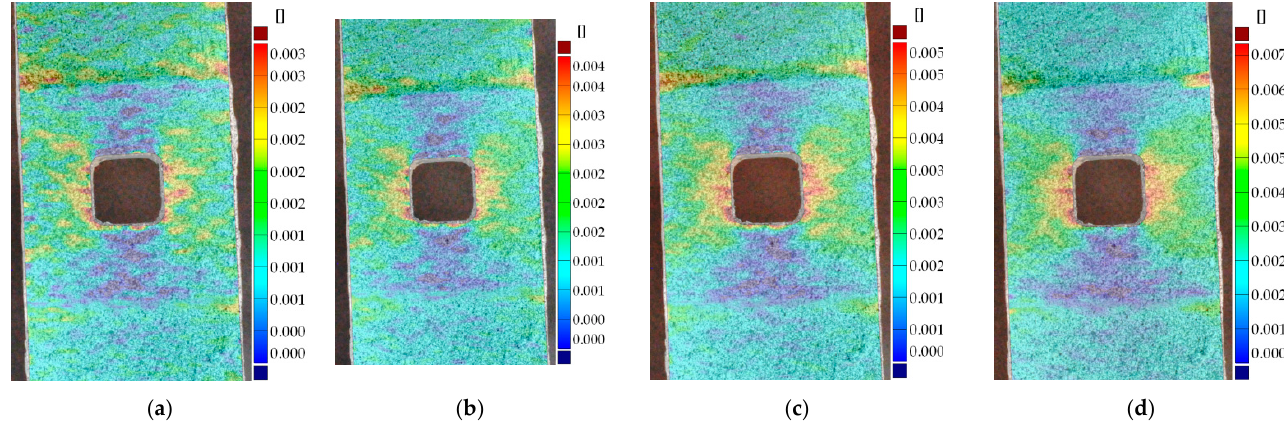
Figure 16. Distribution of strain on surface for sample no. 5 with rectangular holes with a fillet radius of R2 and composite overlays for strain: ( a ) ε TOT = 0.22%; ( b ) ε TOT = 0.27%; ( c ) ε TOT = 0.32%; ( d ) ε TOT = 0.37%.